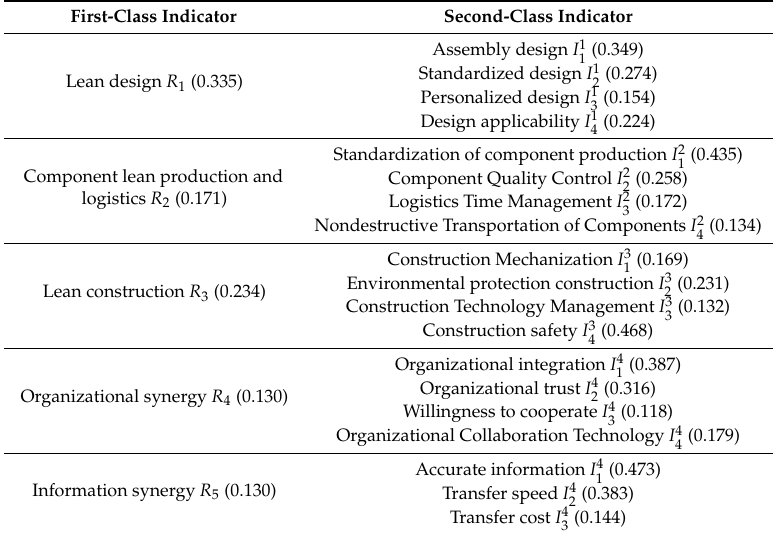
Table 1. Evaluation indicator system and indicator weight.